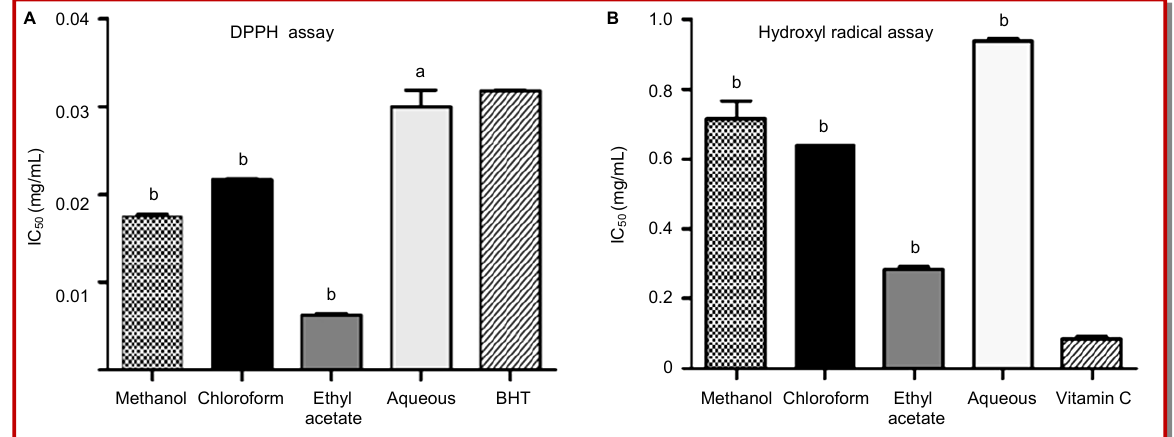
Figure 2: Free radical scavenging activity of different O. glandulosum extracts. Data were presented as IC 50 means ± SD (n = 3); ( a p<0.05, b p< 0.001) compared to butylated hydroxytoluene (BHT) and vitamin C as standards